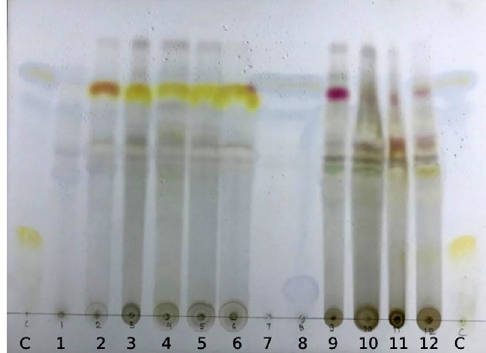
Fig. 1. Thin Layer Chromatography showing chemistry of Usnea longissima (1 & 2 natural thallus, 3 ethanol, 4 methanol, 5 ethyl acetate, 6 acetone extract) and Cetrelia braunsiana (7 & 8 natural thallus, 9 ethanol, 10 methanol, 11 ethyl acetate, 12 acetone extract